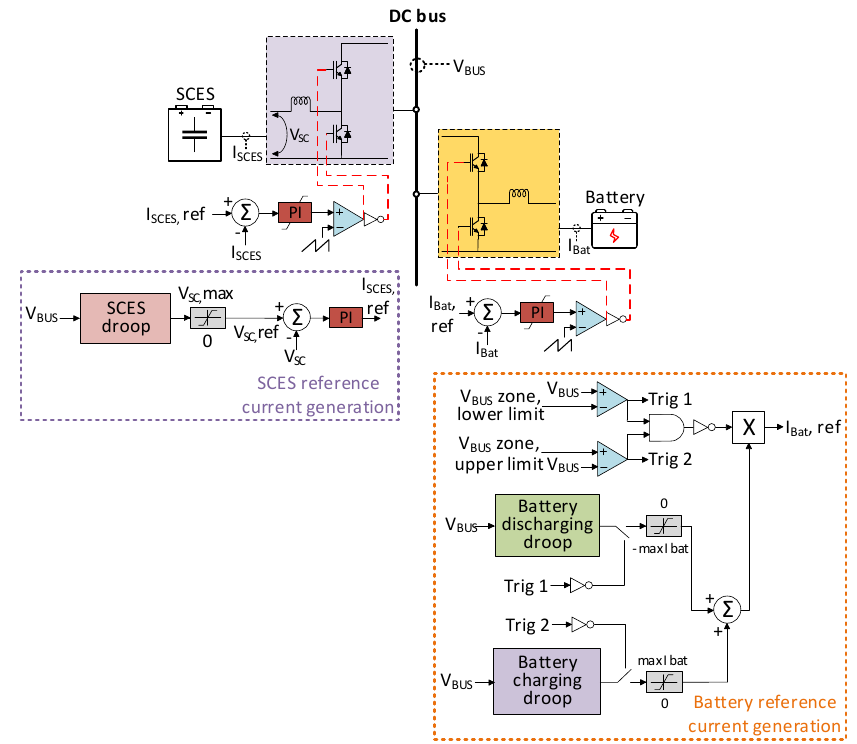
Figure 6. The complete implementation of the SCES/ba tt ery HESS control algorithm.